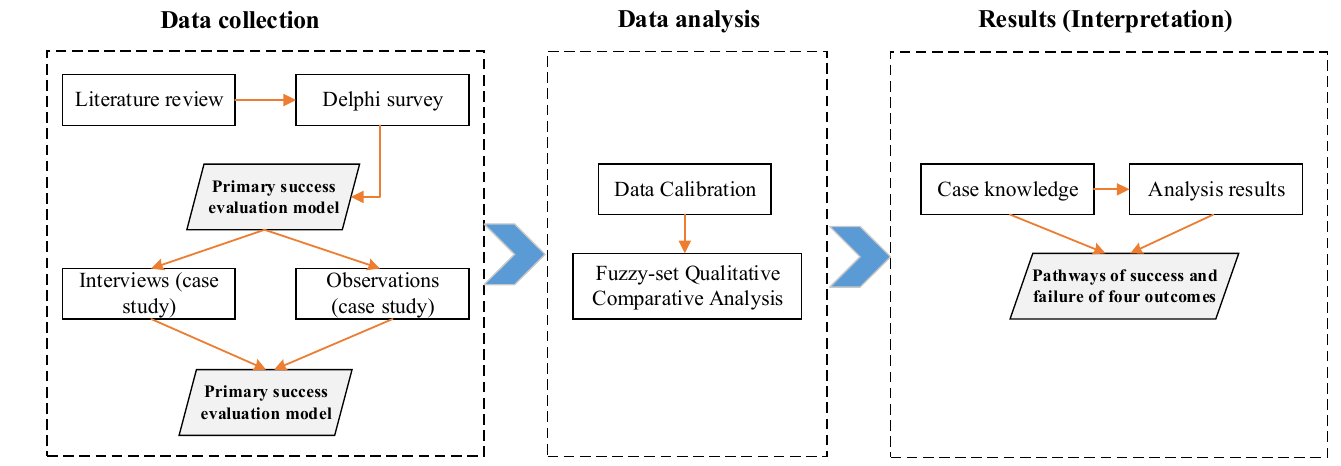
Figure 2. Research steps. Rectangles stand for research tools, while the parallelograms signify research milestones.